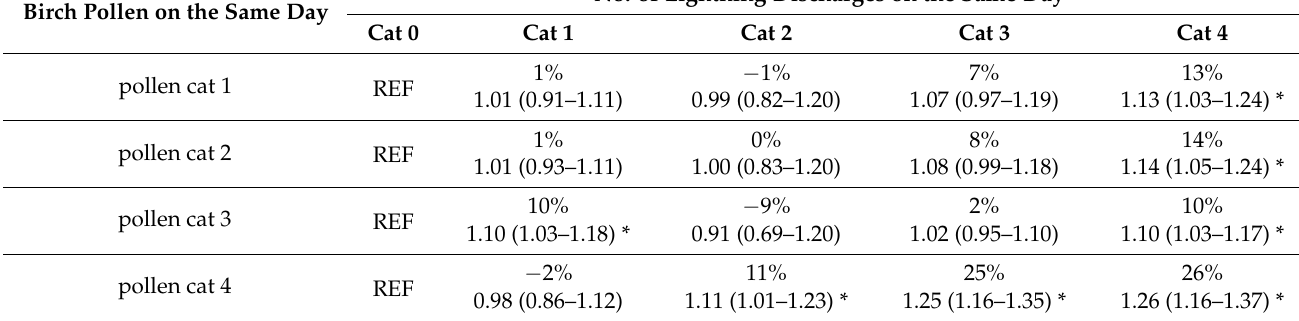
Table 3. The change (%) in the number of daily outpatient visits due to respiratory causes related to the birch pollen concentrations (pollen grains/m 3 /day; in five categories) and the number of lightning discharges per day (in five categories) on the same day. The post-estimation β coefficient values, including the confidence interval (CI) values at the 95% significance level, are depicted below the change estimate (%). Significant results are marked with *.